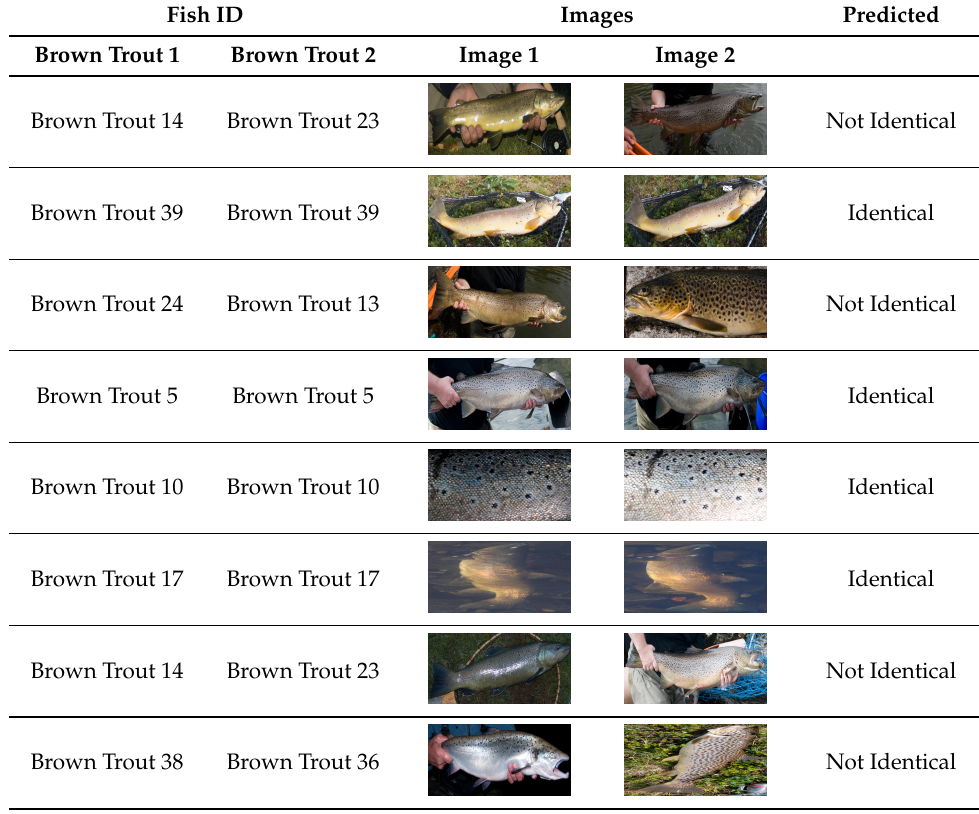
Table 3. Randomly chosen sample fish in the TROUT39 validation dataset that were correctly recognized. Note that the network was trained using under-water videos and the results here show the performance of the identification method for out-of-water fish